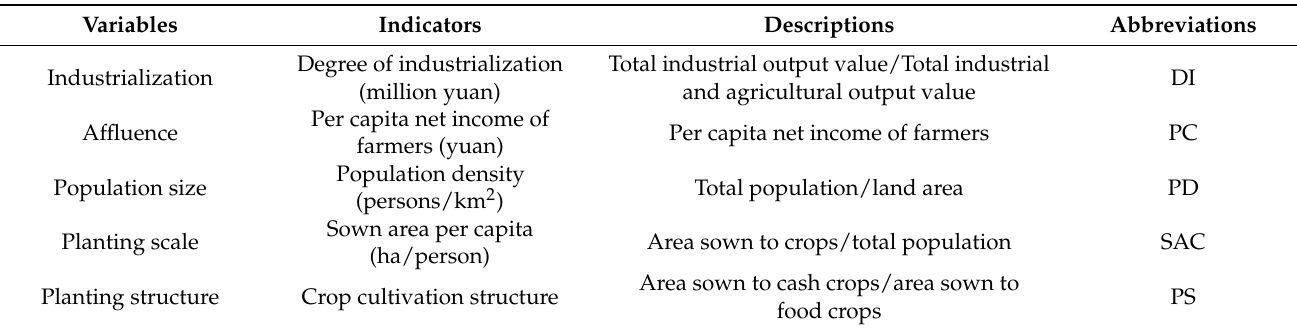
Table 2. Explanatory variables